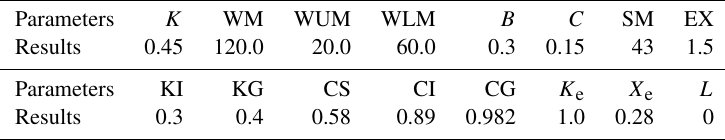
Table 1. The results of parameters calibration in XAJ hourly model. Parameters K WM WUM WLM B EX Results 0.45 Parameters KI KG